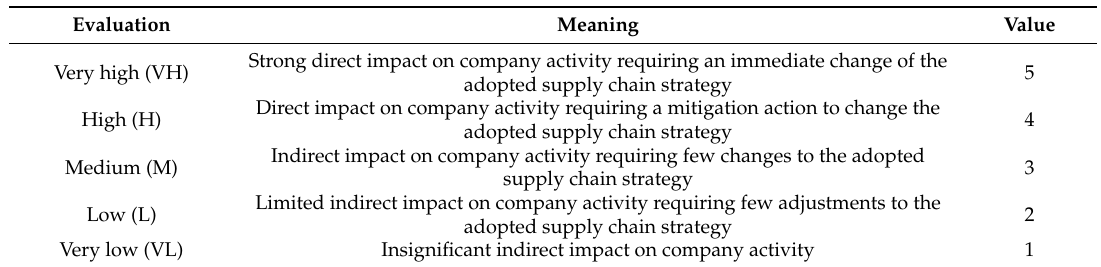
Table 5. Evaluation scale for the factor strategic